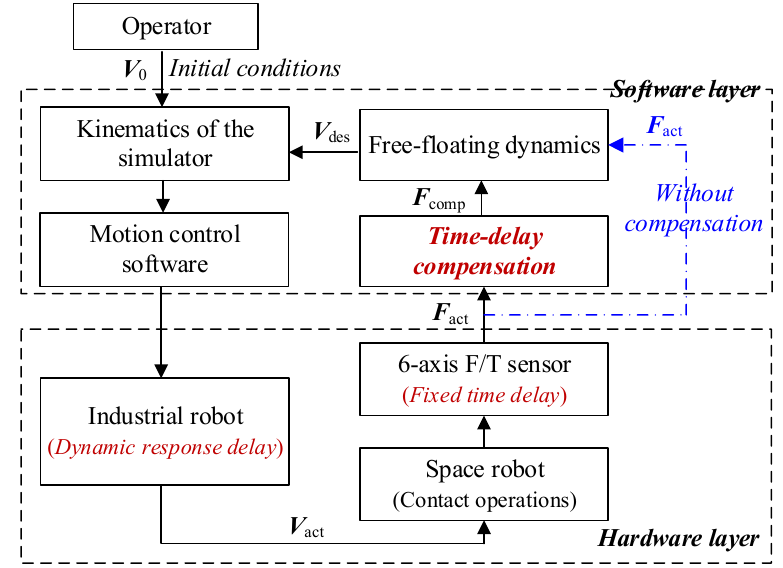
Figure 3. The HIL simulation principle.